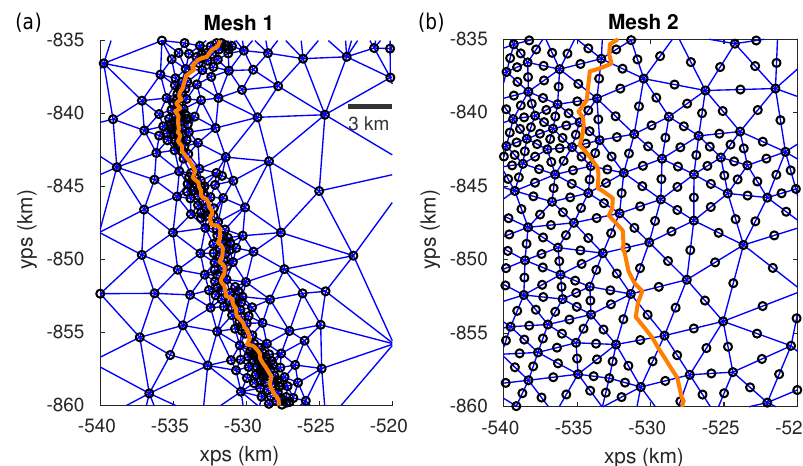
Figure B1. Close-up of the Bindschadler grounding line for two different meshes. (a) Elements and nodes of the mesh presented in the main text. The mesh was refined, especially around the grounding line, and linear 3-node elements were employed. (b) An alternative mesh with 6-node elements with quadratic base functions. The grounding-line position is indicated in both meshes in orange.